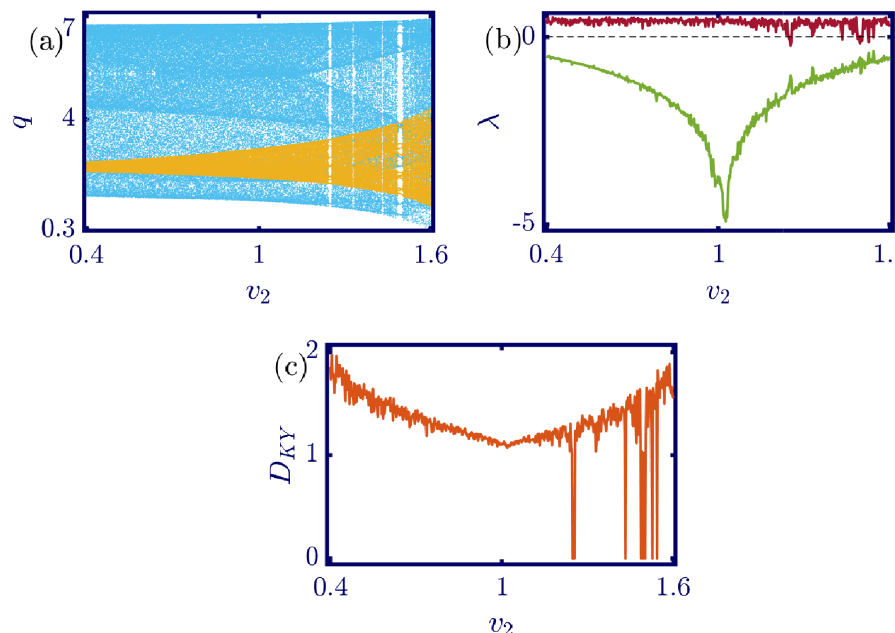
Fig 10. Eq (13) dynamics concerning the parameter v 2 with a = 6, b = 0.5, c 1 = 2, c 2 = 1, d 1 = 0.5, d 2 = 1, v 1 = 0.1 and initial conditions q 1 (0) = q 2 (0) = 1. (a) Bifurcation diagram, (b) Lyapunov exponents spectra, and (c) Kaplan-Yorke dimension. Even though some periodic windows exist, chaotic behavior is the dominant dynamic in the whole parameter interval. It can be deduced that increasing the adaptation speed of the follower firm not only does not control the market but also raises its flexibility and conformity with the market, which are not always appropriate behaviors. In the sub-figure (a), the cyan points represent the data for the leader firm ( q 1 ), whereas, the yellow points represent those for the follower firm ( q 2 ), and in sub-figure (b), the red and green points present the Lyapunov exponent spectra for the leader and follower firms respectively, namely λ 1 and λ 2